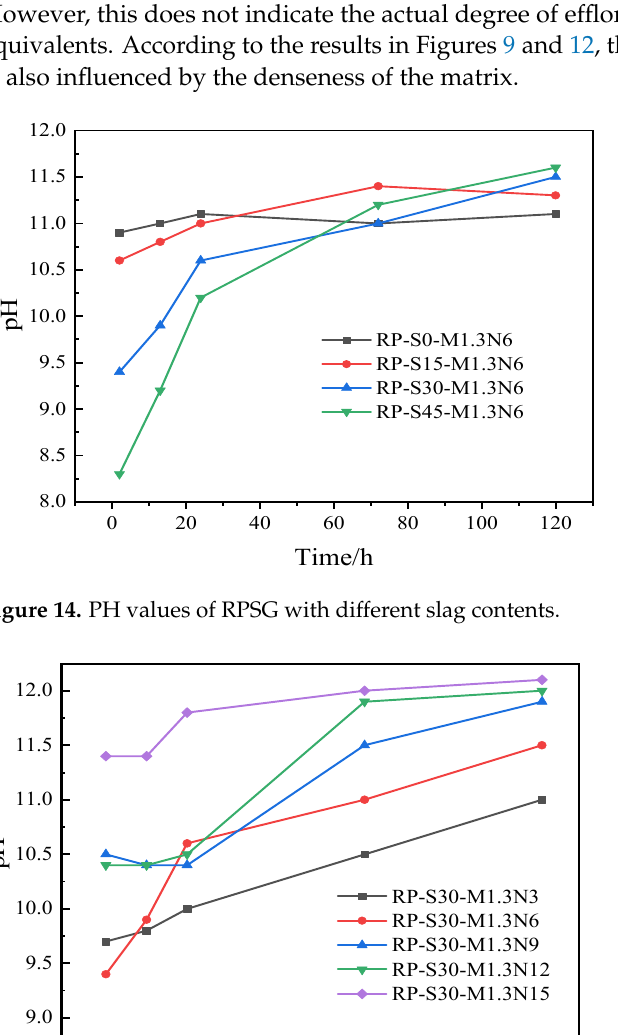
Figure 15. PH values of RPSG with different alkali equivalents.